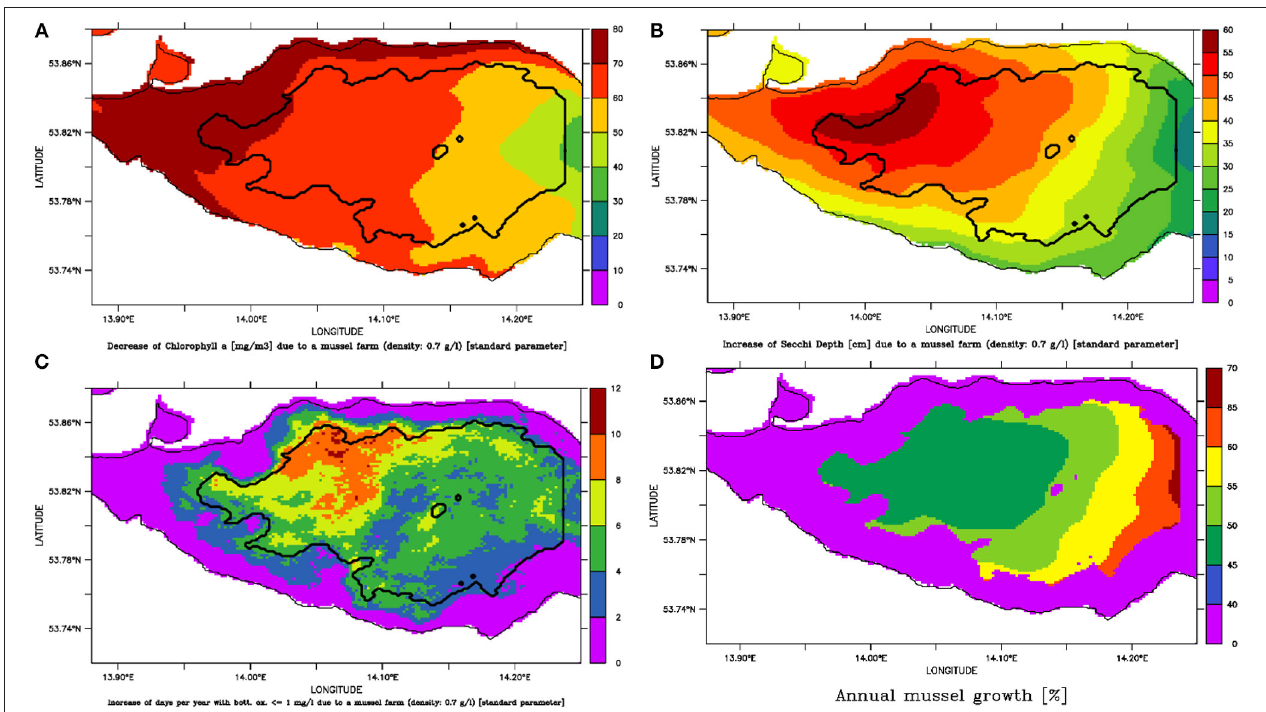
FIGURE 8 | Assuming the large-scale mussel farm option with a mussel density of 0.7mg l − 1 results in (A) a decrease of Summer Chlorophyll a (mg m − 3 ); (B) an increase of Summer Secchi Depth (cm); (C) an increase of number of days per year with bottom oxygen below 1mg l − 1 and (D) a potential mussel growth per year (potential harvest divided by the